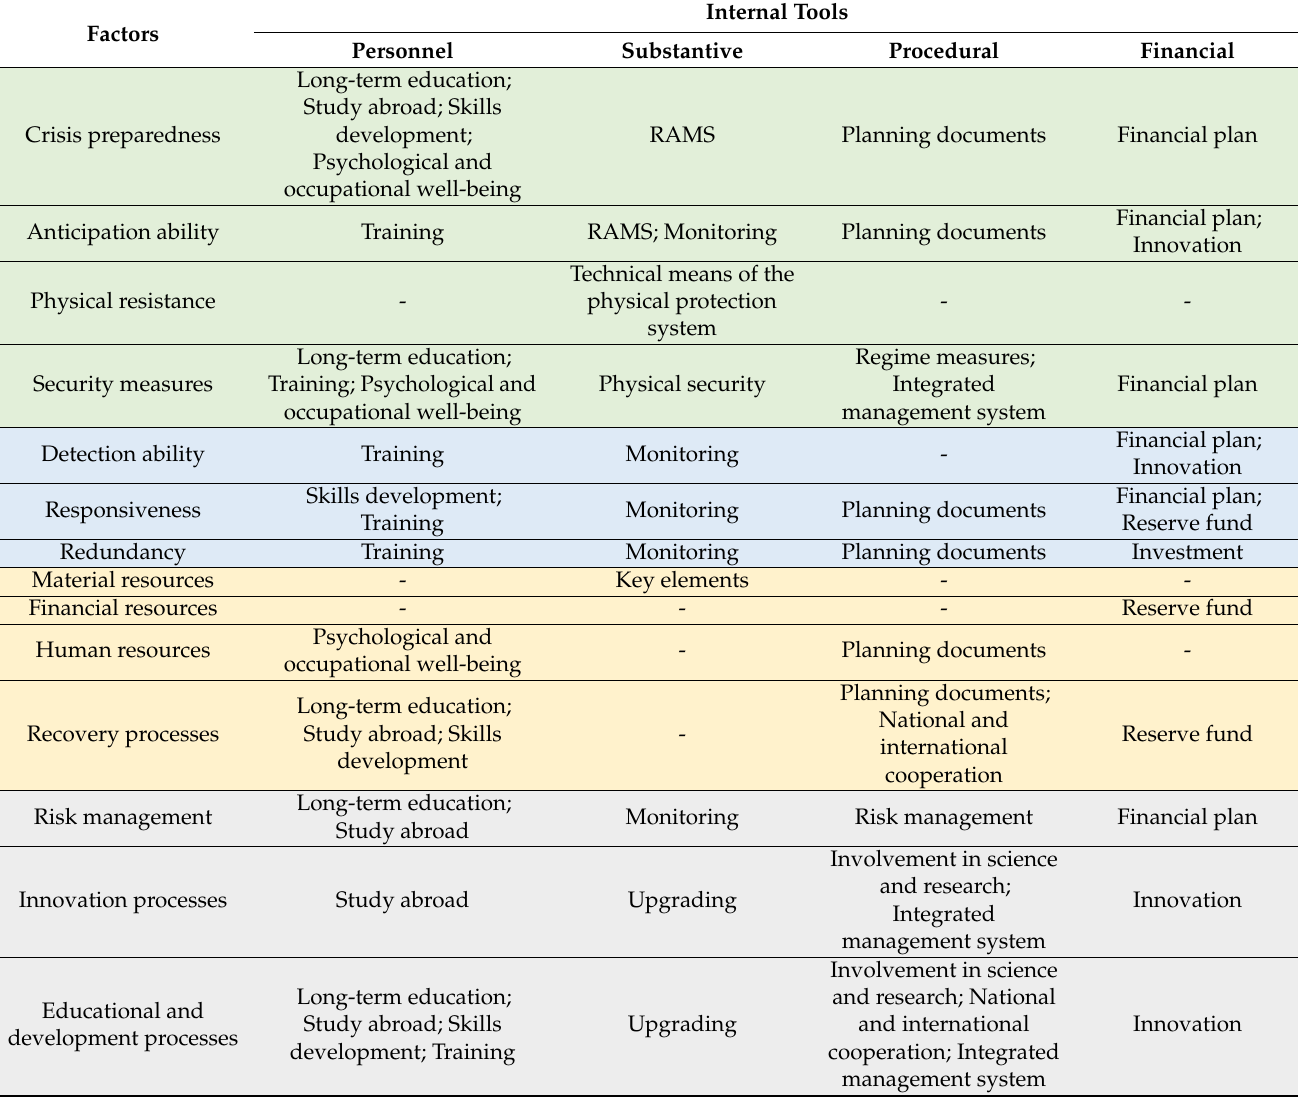
Table 3. Matrix for selecting internal resilience-strengthening